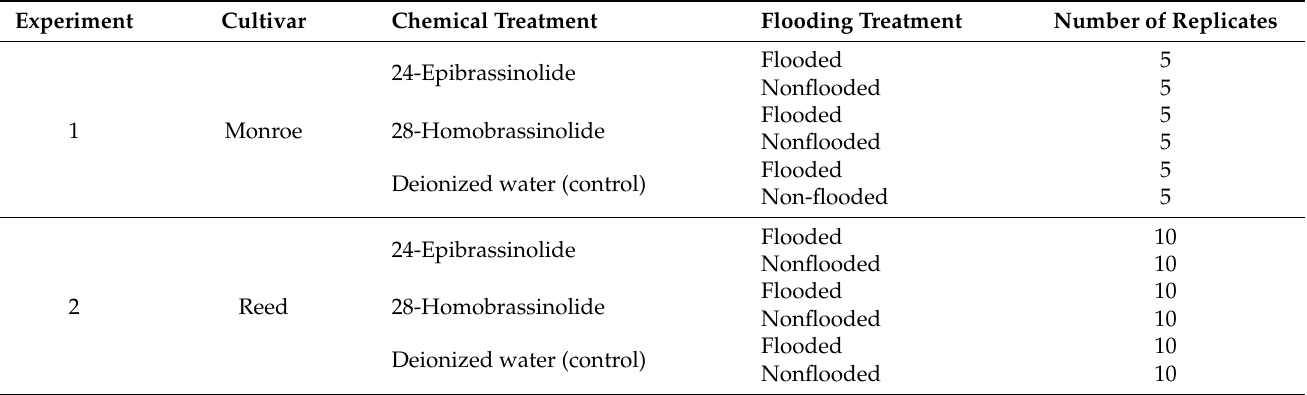
Table 1. Plant material, treatments, and number of replicates used for brassinosteroid priming of seedling avocado trees used in Experiments 1 and